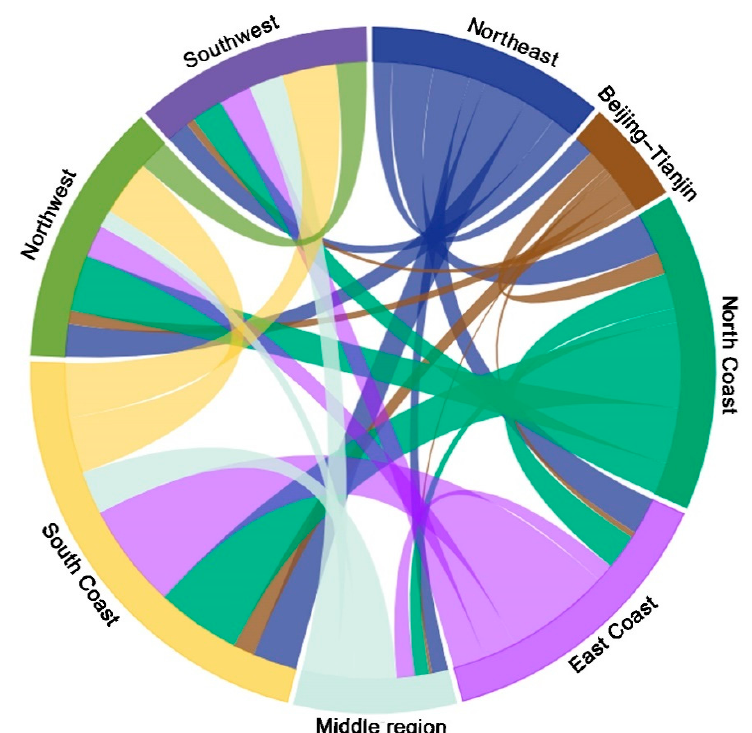
Figure 3. Inter-regional embodied agricultural land transfer.